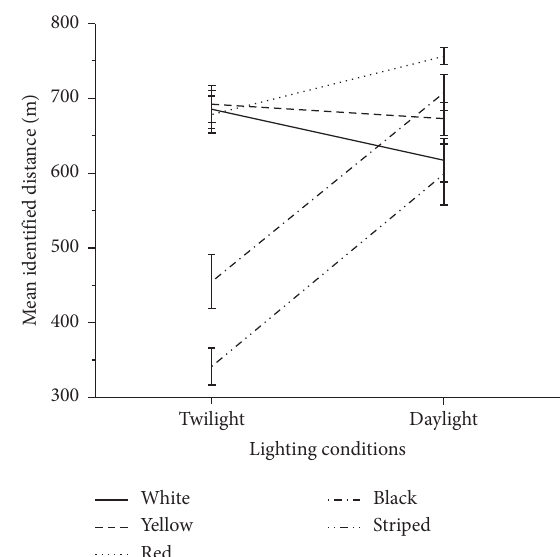
Figure 5: Interaction effects of lighting conditions and vehicle